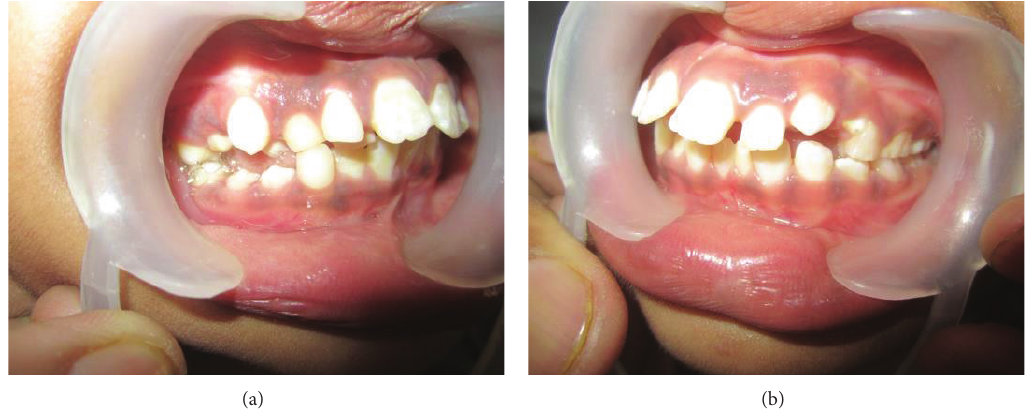
Figure 4: Intraoral right and left occlusal views showing mixed dentition.